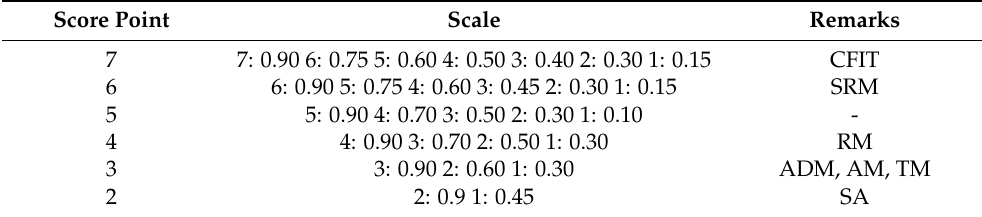
Table 3. Measuring Scale for Modifying Relative Importance of AHP.